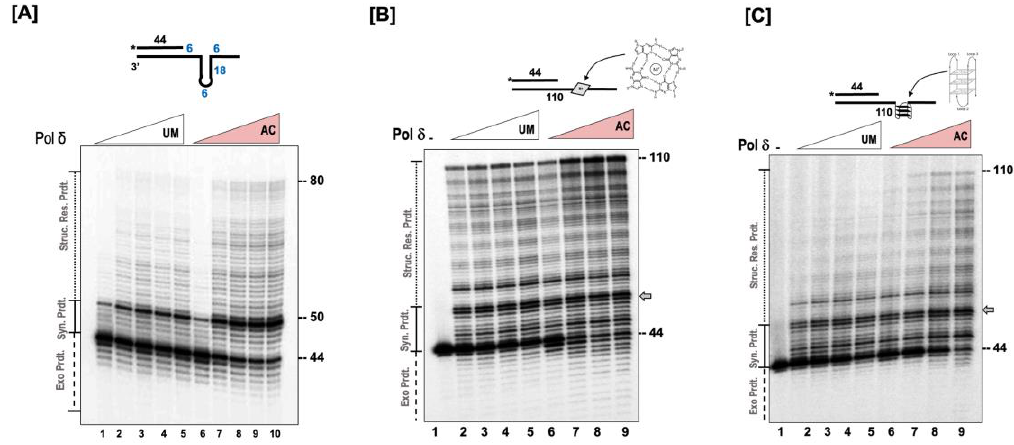
Figure 4. Acetylation stimulates the structure resolution activity of pol δ . ( A ) The structure resolution activity of pol δ was assayed using 5 nM of substrate containing a fold-back in the template (U 1 :T 4 ) incubated with the either unmodified (UM) or acetylated (AC) forms of pol δ (20, 50, 100, 200, 400 nM) as indicated in the figure and as described in the “Section 2.6”. The concentration-dependent structure resolution activity of pol δ was assayed using ( B ) a substrate (U 1 :T 5 ) containing a G-quartet in the template or ( C ) a substrate (U 1 :T 6 ) containing a G-quadruplex in the template at varying concentrations of either unmodified or acetylated pol δ (20, 50, 100, and 200 nM) as described in the “Section 2.6”. The substrate is depicted above each gel image and the asterisk denotes the location of the radiolabel. Exonuclease products (Exo. Prdts.), synthesis products (Syn. Prdts.), and strand displacement product (Strd. Disp. Prdts.) are indicated adjacent to the gel image. Nucleotide sizes are also indicated.